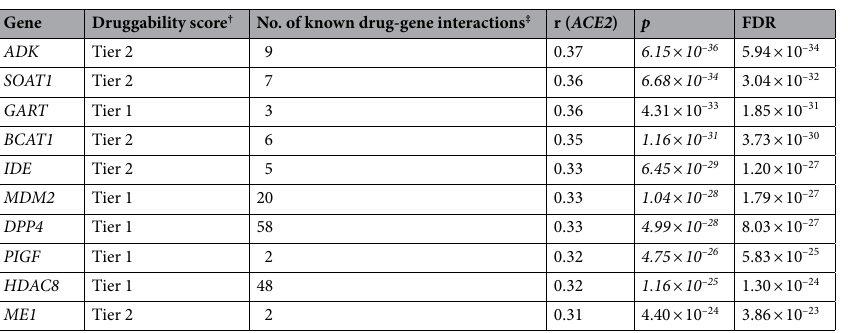
Table 2. Drug-gene interactions of ACE2 -correlated genes. † From Finan et al. 12‡ From Drug-Gene Interaction Database (DGIdb) 13 . r( ACE2 ): Pearson correlation coefficient between gene and ACE2 expression (adjusted for sex age and centre). p: significance of the Pearson correlation coefficient (corresponds to Fisher’s Z score value), adjusted for false discovery rate (FDR).